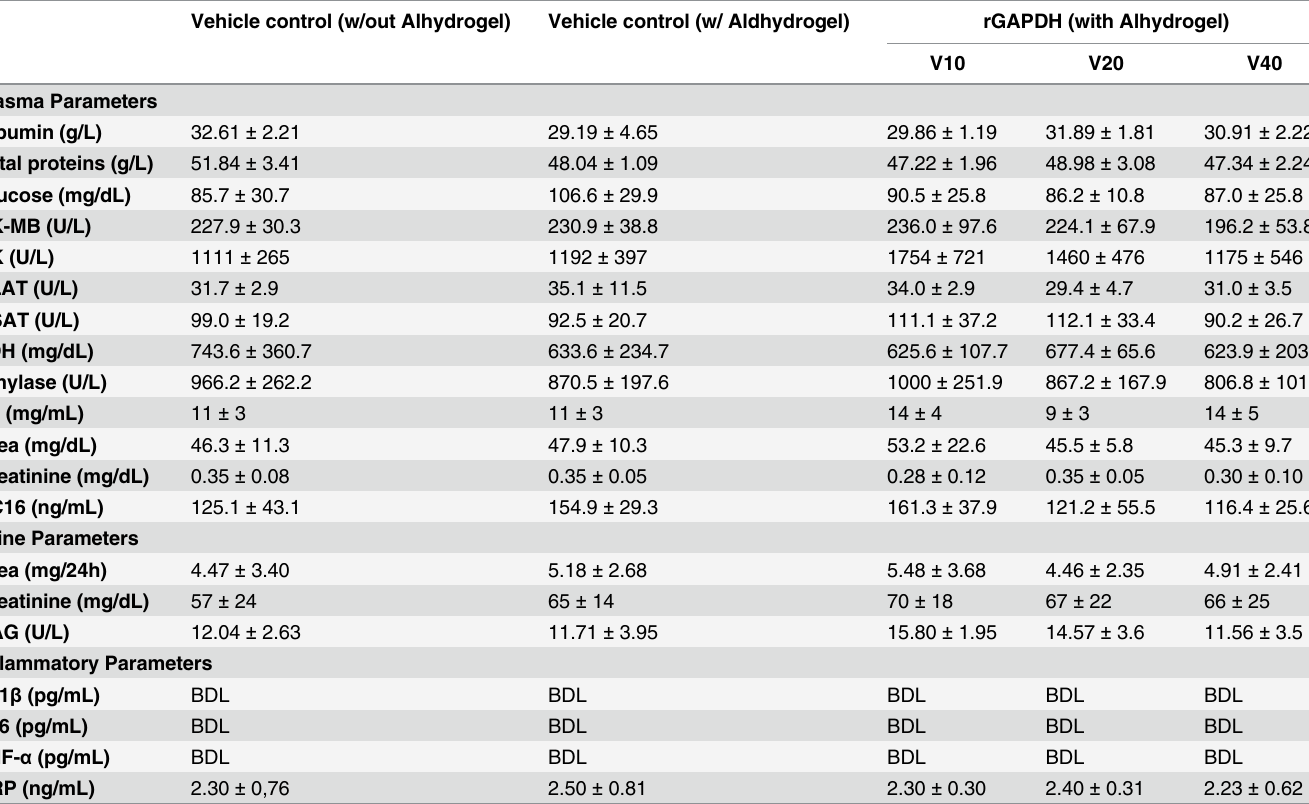
Table 2. Biochemistry of plasma and urine collected 24h after the last vaccine injection. Vehicle control (w/out